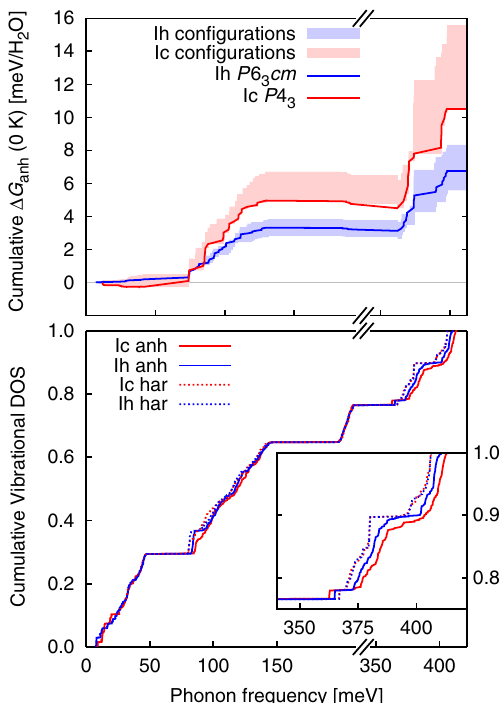
FIG. 8. Cumulative anharmonic energies and vibrational DOS of H 2 O averaged over proton orderings as a function of frequency. The upper panel shows the anharmonic energies for Ih Cmc 2 1 and Ic P 4 3 as solid blue and red lines and the spread in free energies in Ih and Ic due to different proton orderings as light red and light blue areas. The lower panel shows that the harmonic DOS of Ih and Ic (dotted lines) are practically identical. The larger increase in vibrational energy due to anharmonicity in Ic than in Ih is reflected in the shifts of their anharmonic DOS (continuous lines) with respect to the harmonic